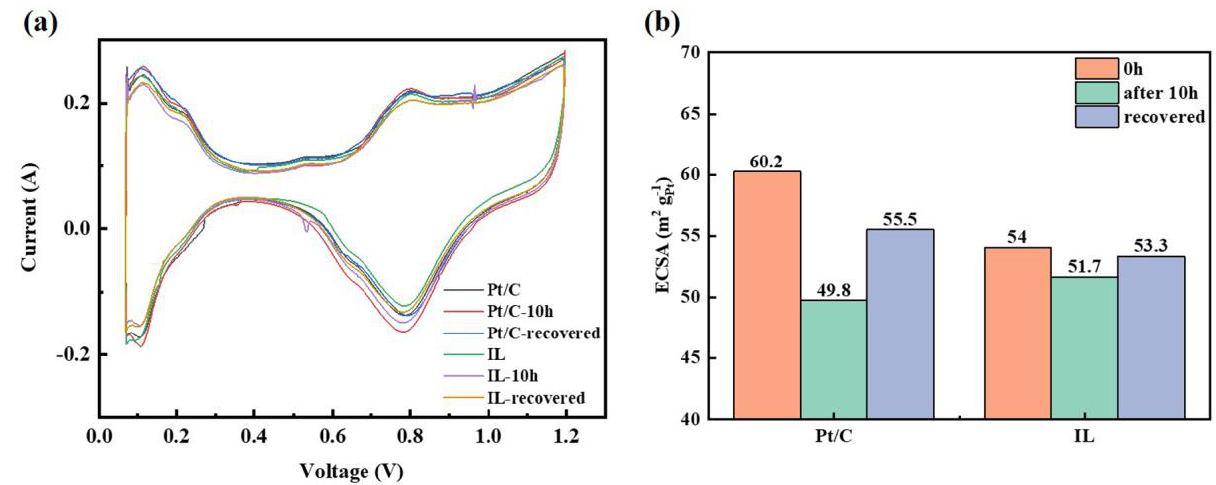
Figure 5. The CV curve of Pt/C and Pt/C + IL ( a ) and ECSA statistics ( b ). In order to determine the Pt oxide in the CL more intuitively, the catalyst was analyzed by XPS. Figure 6a–f, respectively, show the curves of the Pt/C catalyst and Pt/C + IL catalyst before the durability test, after the durability test and after CV recovery. Pt (II) and Pt (IV) correspond to the different oxidation valence states of Pt. According to Formulas (1)–(3), the main divalent oxides of Pt are PtOH and PtO, and the tetravalent oxide is PtO 2 . Without any experiment, the XPS maps of both Pt/C and Pt/C + IL contained Pt peaks, and their relative peak areas were similar. The total oxide content in Pt/C-0 h (38.42%) was higher than that in Pt/C + IL-0 h (35.69%). Table 1 shows the Pt oxide content of Pt/C and Pt/C + IL under three conditions. Among them, the relative peak areas of Pt (II) and Pt (IV) in Pt/C-10 h increased significantly and still could not be eliminated after CV recovery. After the 10 h durability test, the relative peak areas of Pt (II) and Pt (IV) reached 32.52% and 11.64%, respectively. Moreover, after the recovery procedure, the relative peak areas of Pt (IV) still remained at 9.39%. It could be considered that a stable and unrecoverable inactive oxidation substance was formed. Pt/C + IL confirmed the above discussion. The relative peak area of Pt (II) in Pt/C + IL changed little before and after the durability test. In addition, the peak of Pt (IV) completely disappeared after CV recovery. This explains why the performance of Pt/C + IL catalyst was good overall and how the performance was completely recovered after CV recovery. Compared with pure Pt, the overall oxidation state of Pt in a hydrophobic environment is low, and it is difficult to form stable oxide. It improves the stability of the catalyst and provides a guarantee for the long-term efficient operation of